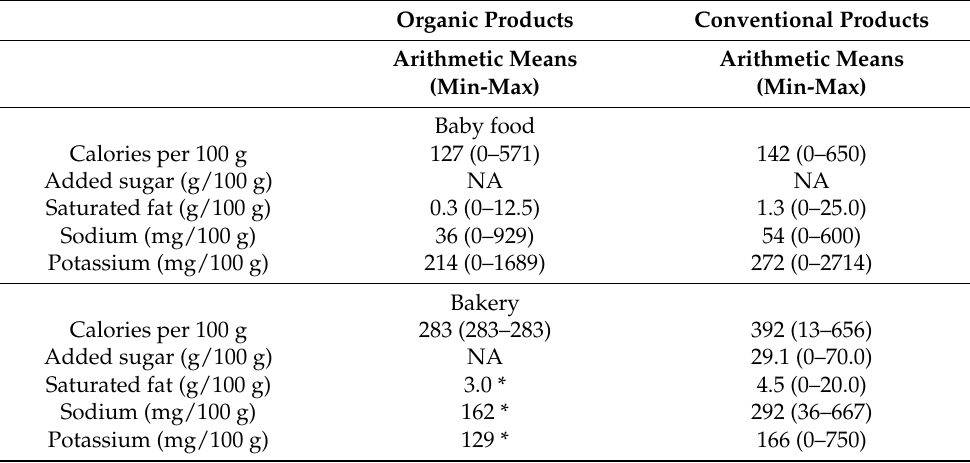
Table A2. Nutritional characteristics by 51 aisles for organic and conventional products per 100 g serving for 3661 organic and 28,596 conventional products that had complete nutritional